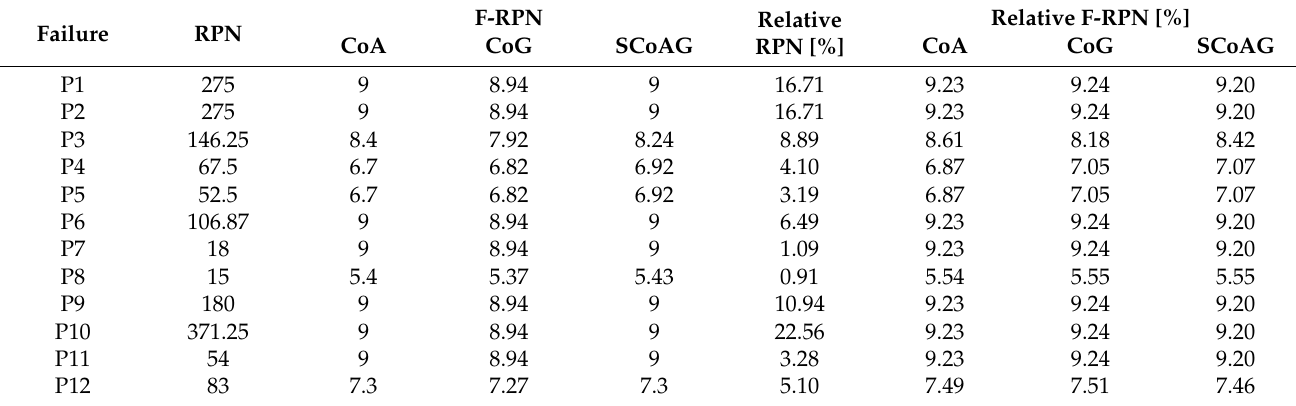
Table 7. Comparative